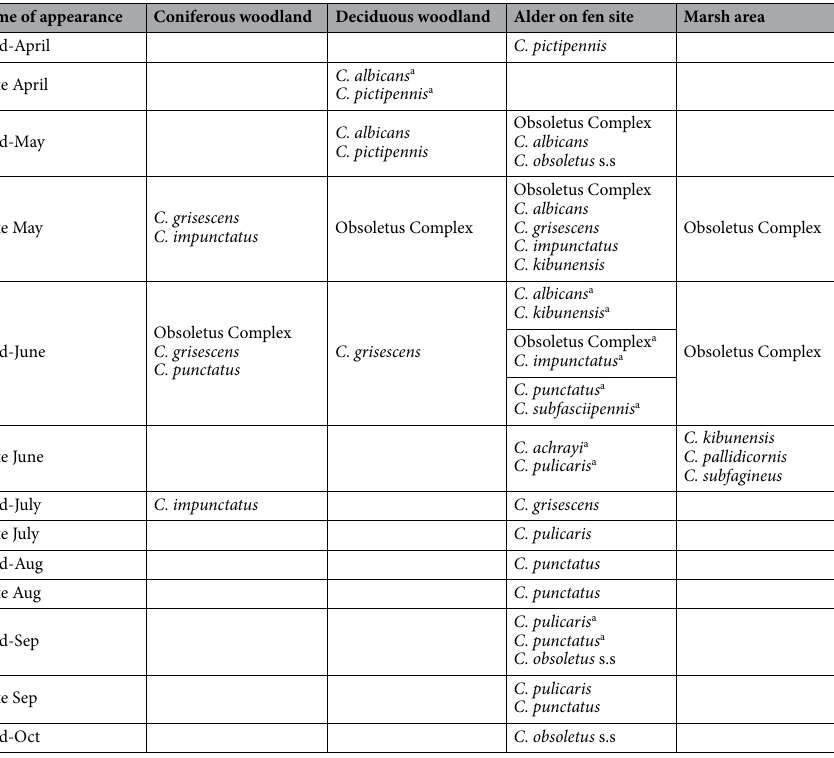
Table 8. Co-occurrence and species distribution per month and biotope of Culicoides spp. collected during 2014. a Species collected in one single